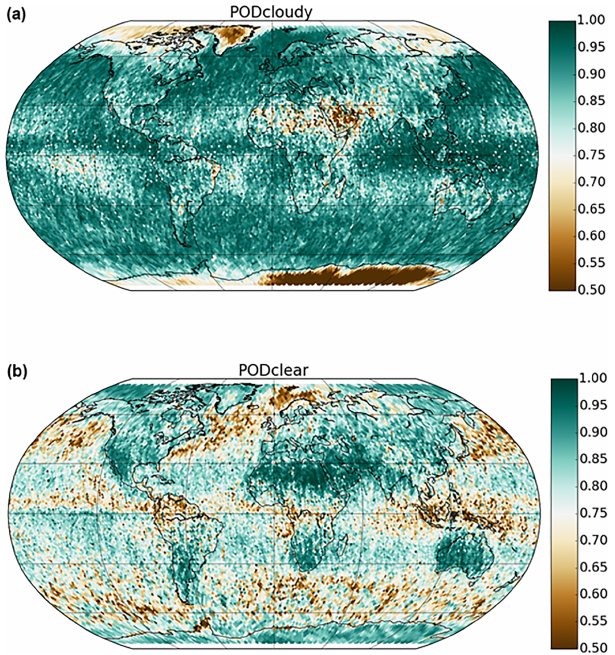
Figure 9. Probability of detection of cloudy (a) and clear (b) condi- tions for the CLARA-A2 cloud mask achieved after filtering the CALIOP cloud mask with the cloud optical thickness value of 0.225. Same underlying matchup data set as in Fig. 2. Results are presented in a Fibonacci grid with 75km resolution.